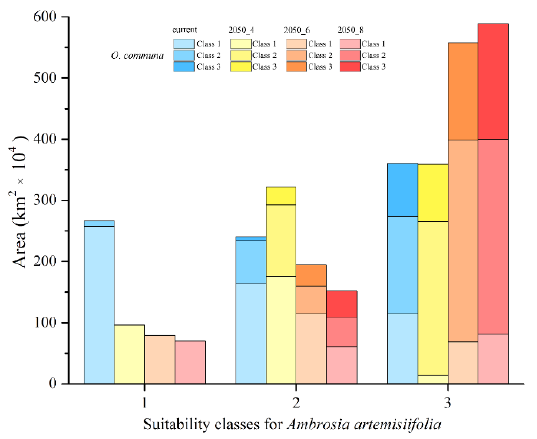
Figure 4. Shared predicted suitable areas for Ambrosia artemisiifolia and Ophraella communa for current and future climate scenarios. Areas (cumulative) shared by Ambrosia artemisiifolia and Ophraella communa in the three different suitability classes (class 1 = low; class 2 = medium; class 3 = high) predicted by the models, performed for each different time frame considered.